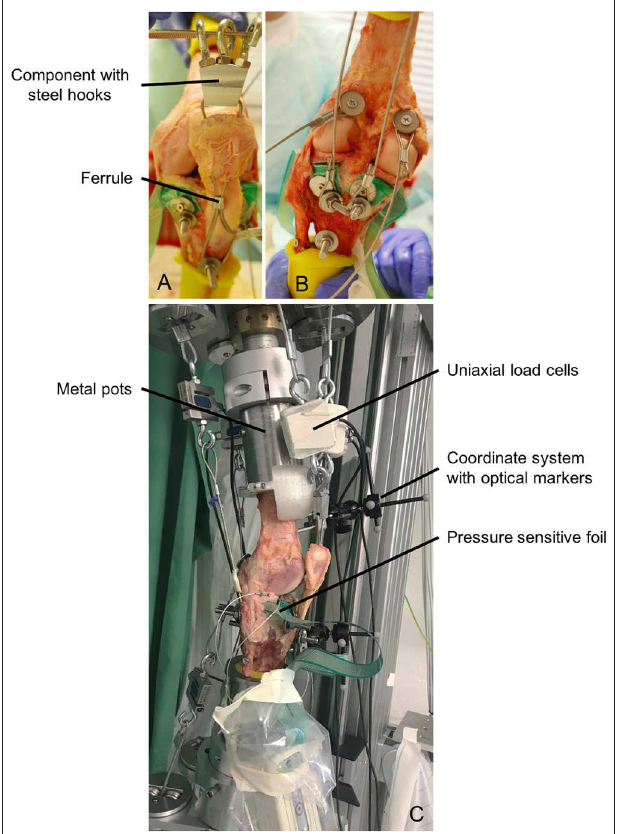
FIGURE 3 | (A) Muscle force simulation of the quadriceps muscle using a threaded rod, steel cable, component with steel hooks and a ferrule. (B) Muscle force simulation of the hamstring and gastrocnemius muscles using threaded rods, dowels and steel cables. (C) Specimen fixed in the dynamic knee joint simulator with cylindrical metal pots, uniaxial load cells for measuring muscle forces, pressure-sensitive foil for measuring the tibiofemoral contact pressure and coordinate systems with optical markers for measuring the